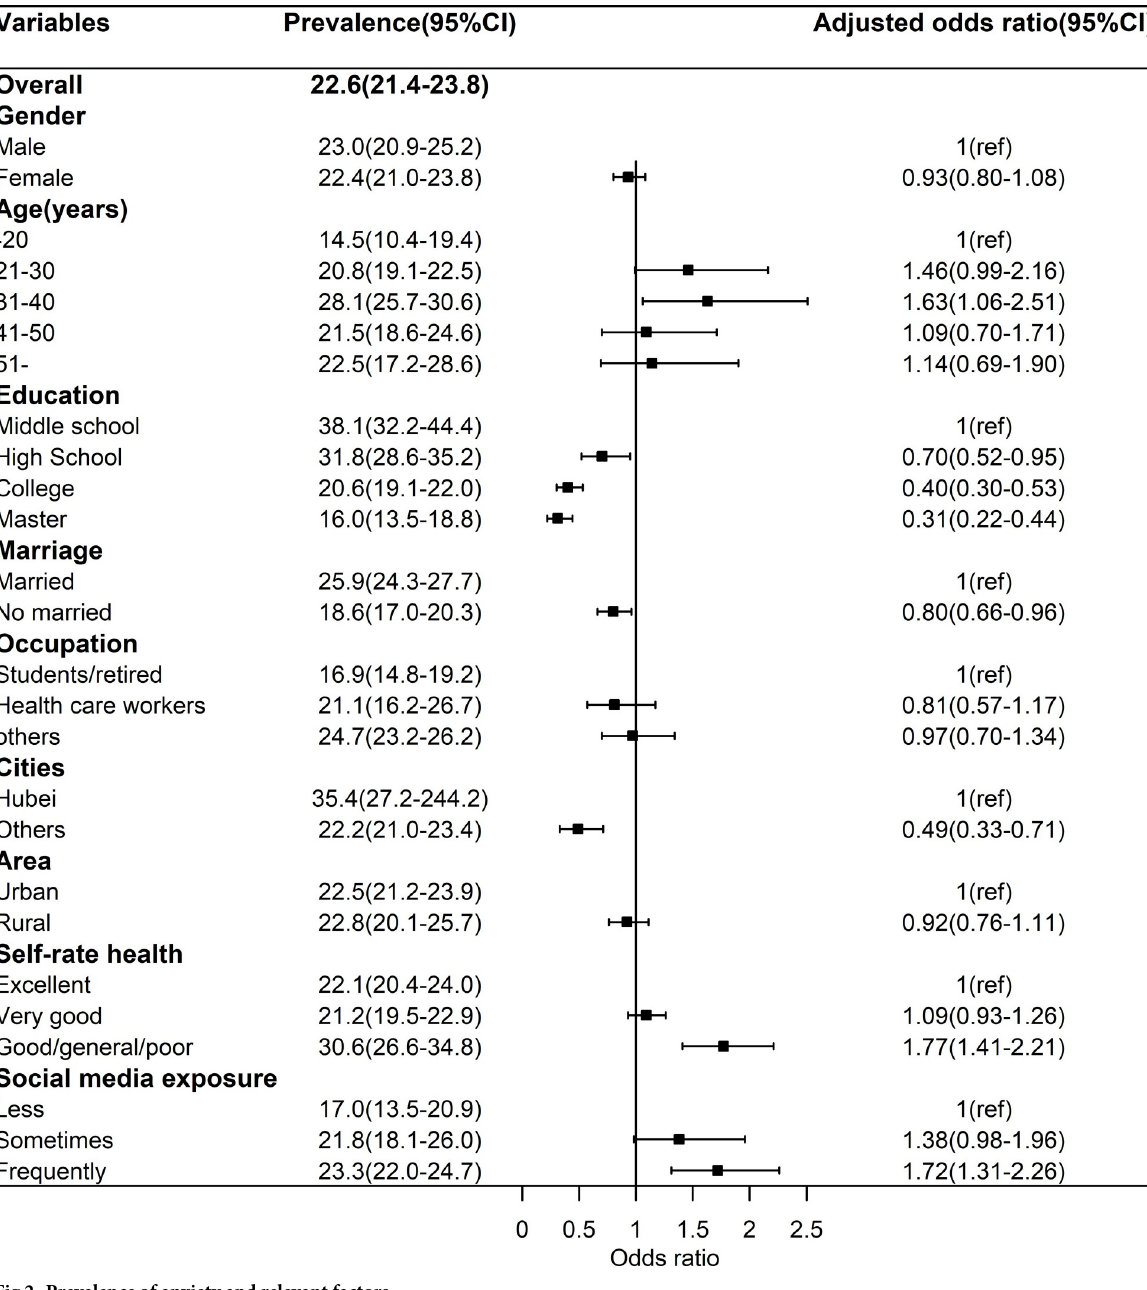
Fig 2. Prevalence of anxiety and relevant